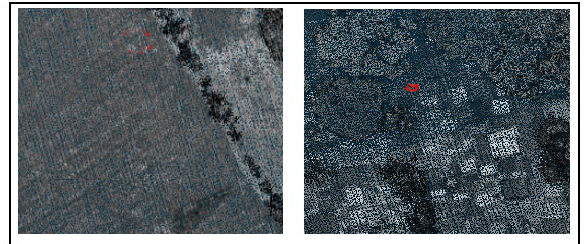
Figure 6. Examples of false negatives produced by the 3D PointConv model. The red shapes show archaeological sites that the model was unable to detect.